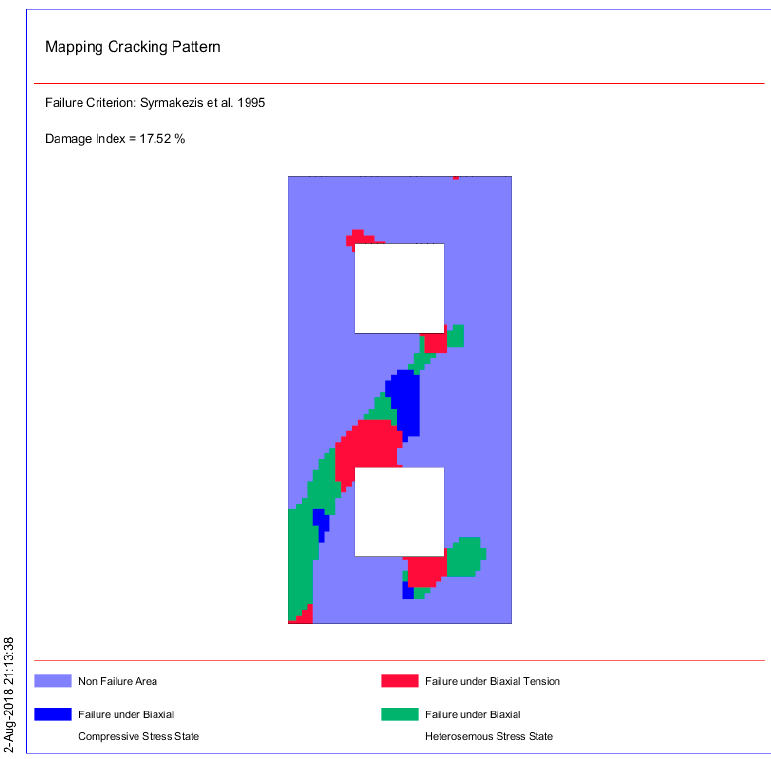
Figure 30. Mapping cracking pattern based on Syrmakezis et al.’s (1995) failure criterion.